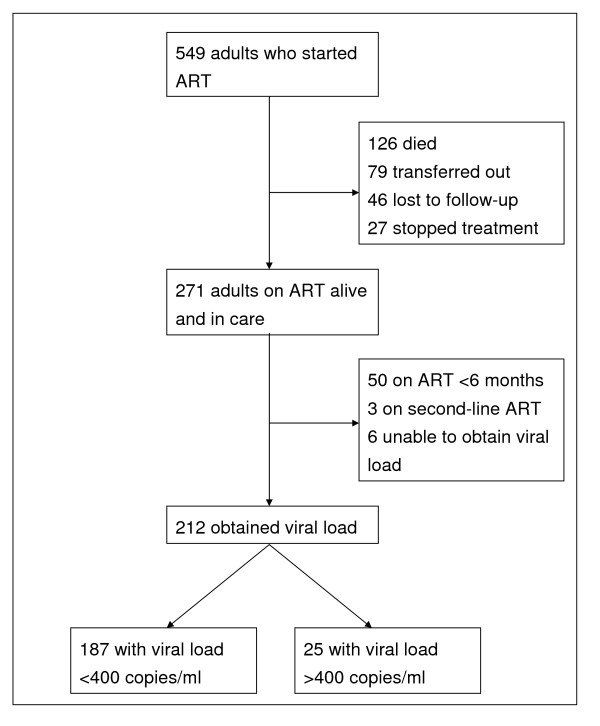
Profile of the study cohort, Haydom Lutheran Hospital, Tanzania, 2003–08.